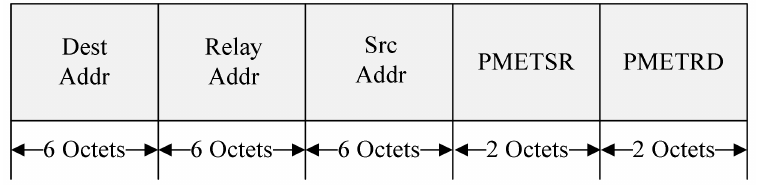
Figure 6. The format of the proposed Path Info